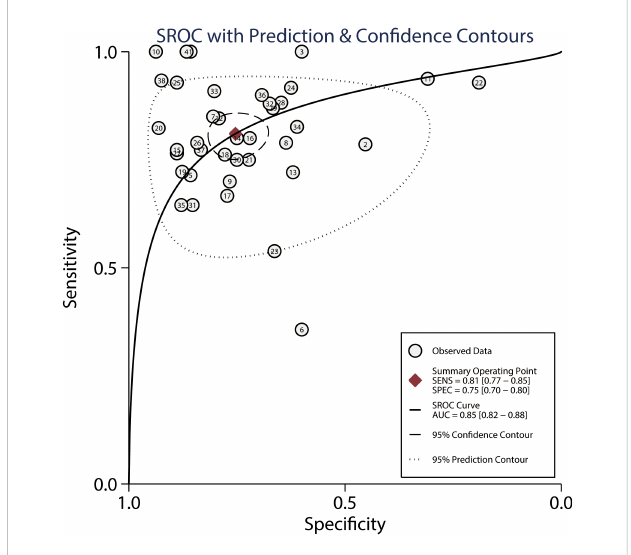
FIGURE 8 Summarized ROC curve and AUC for FDG-PET and